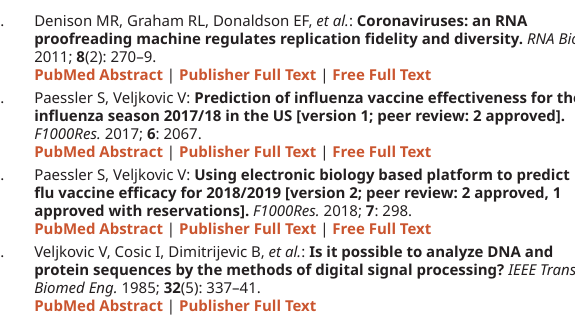
ISM-based monitoring of the evolution of SARS-CoV-2 is important for identification of other mutations, which could affect the effectiveness of vaccines against this